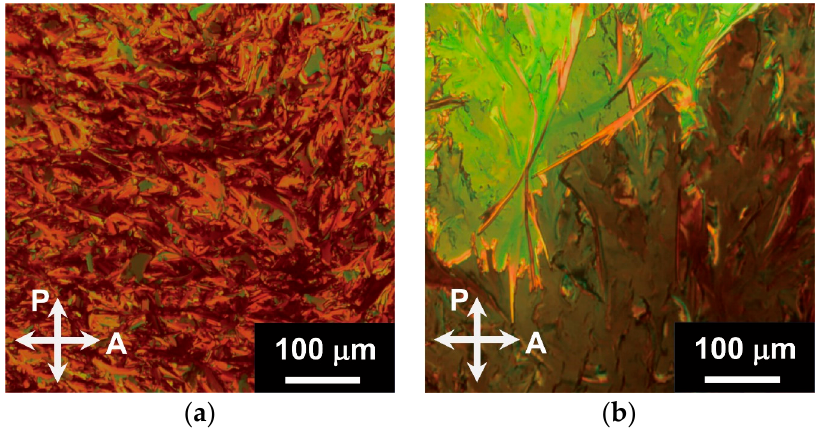
Figure 3. POM images of ( R )- 2 at ( a ) 120 °C, ( b ) 105 °C, ( c ) 90 °C, and ( d ) 45 °C.